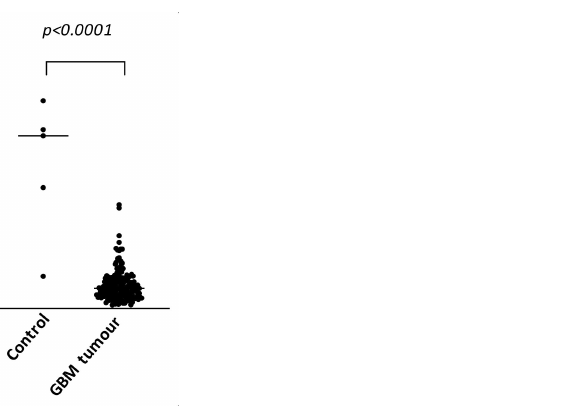
Figure 3. RAPGEF1 mRNA levels in GBM patient tumour samples compared with healthy brain. Analysis of RAPGEF1 expression in control ( n = 5) and GBM patient samples ( n = 166) using data from the TCGA database. RAPGEF1 mRNA levels normalised with ACTB (left panel) or GUSB (right panel). U-Mann–Whitney test was used to compare the data and p values are shown.